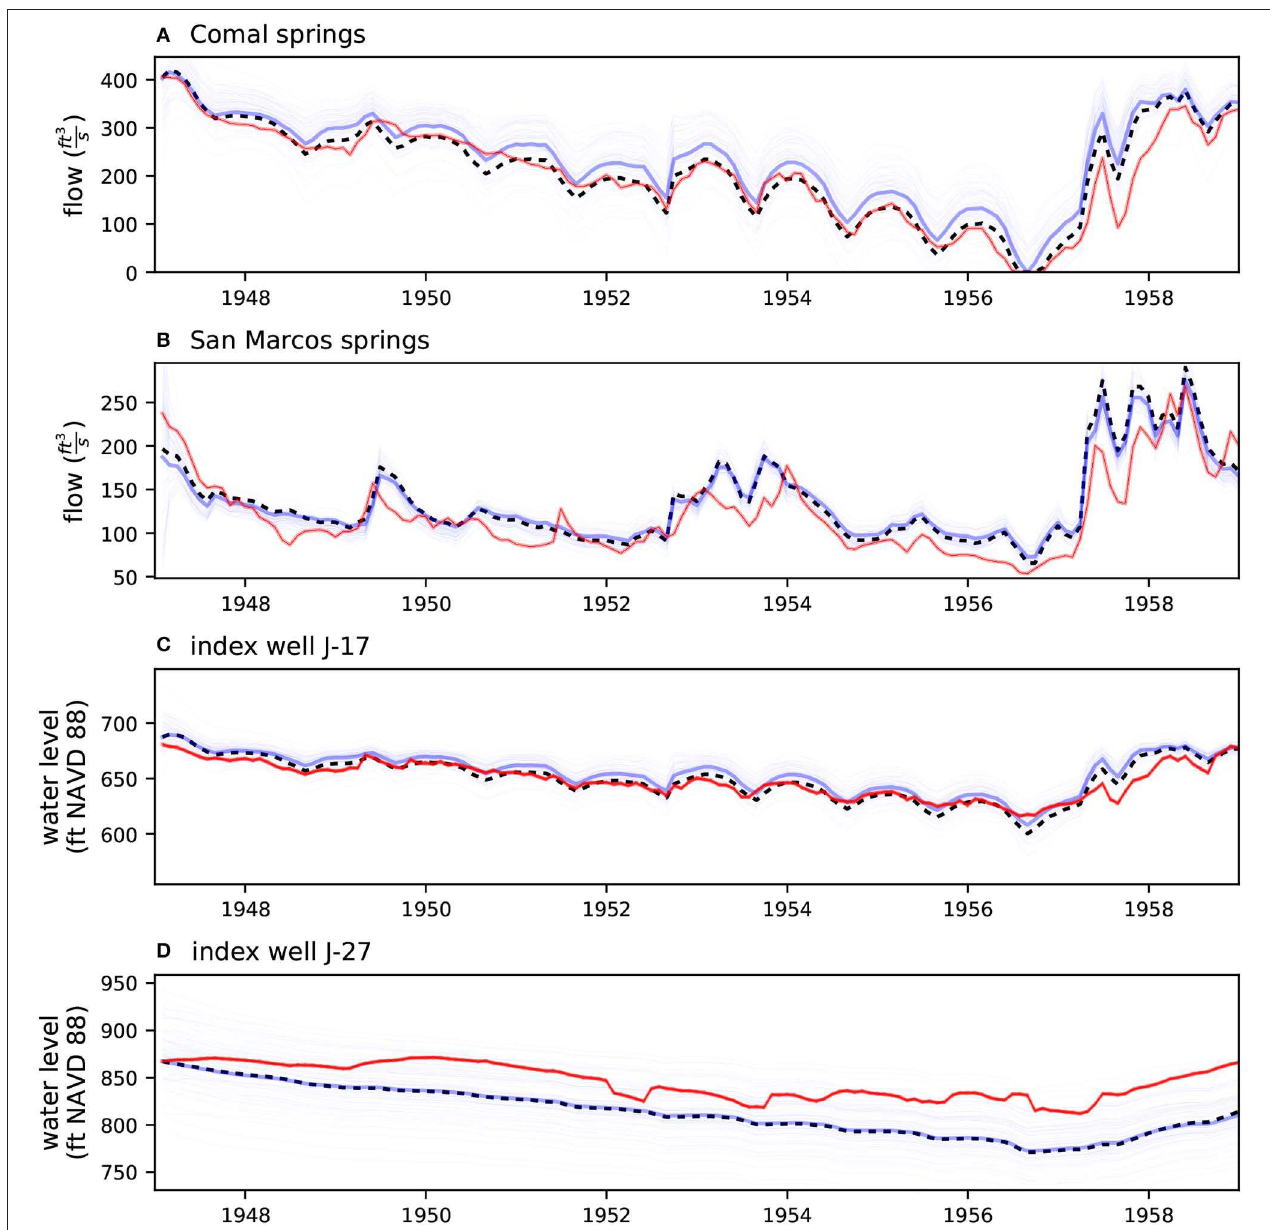
FIGURE 3 | Observed vs. simulated plots for the four locations of primary interest to groundwater resource managers for the scenario simulation. Red trace is the observed series, dashed black trace is the existing simulation results from Liu et al. (2017), thick blue trace is the maximum a posteriori simulation result, light blue traces are the posterior ensemble simulation results. The posterior ensemble brackets the observed series, however, some uncertainty remains, which we attribute to the scenario simulation forcing